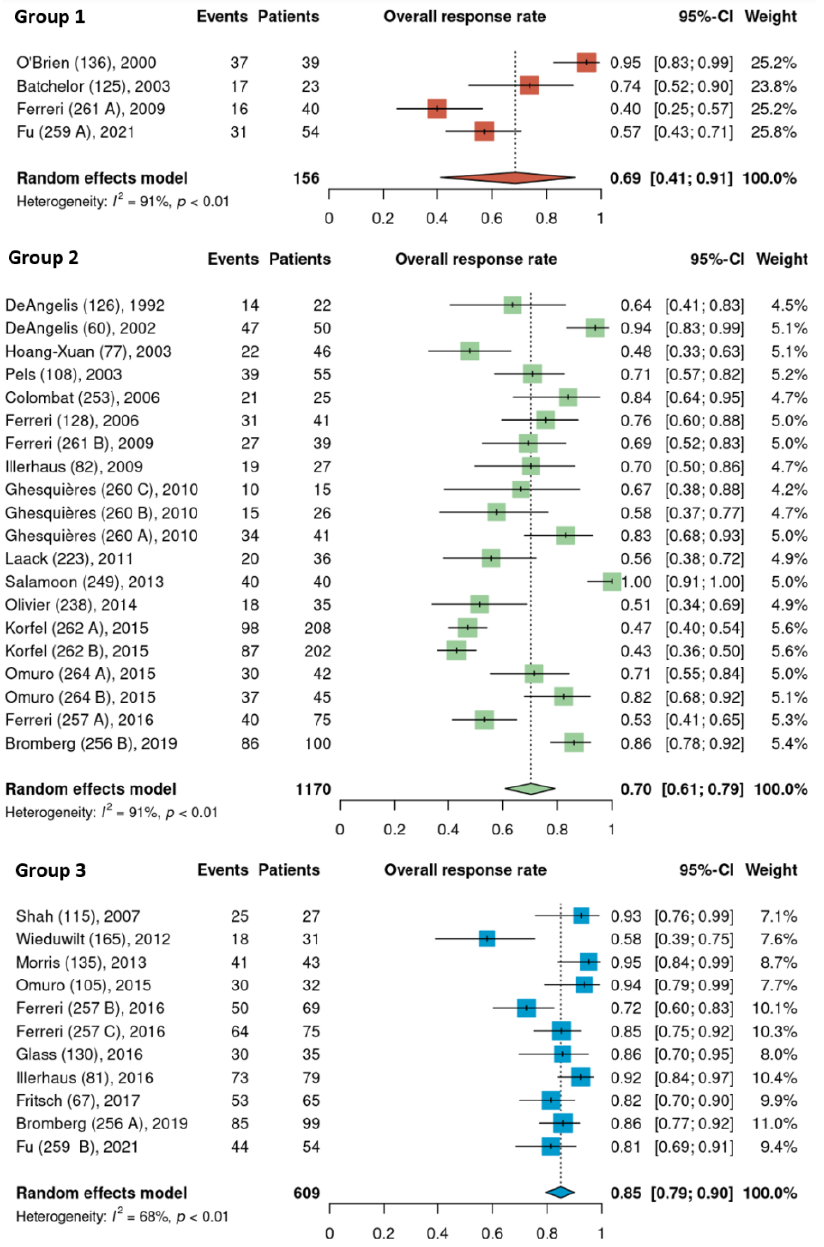
Figure 3. Overall response rates of the different HDMTX induction regimens. Group 1, HDMTX monotherapy. Group 2, HDMTX + polychemotherapy. Group 3, HDMTX + rituximab ± polychem- monotherapy. Group 2, HDMTX + polychemotherapy. Group 3, HDMTX + rituximab ±